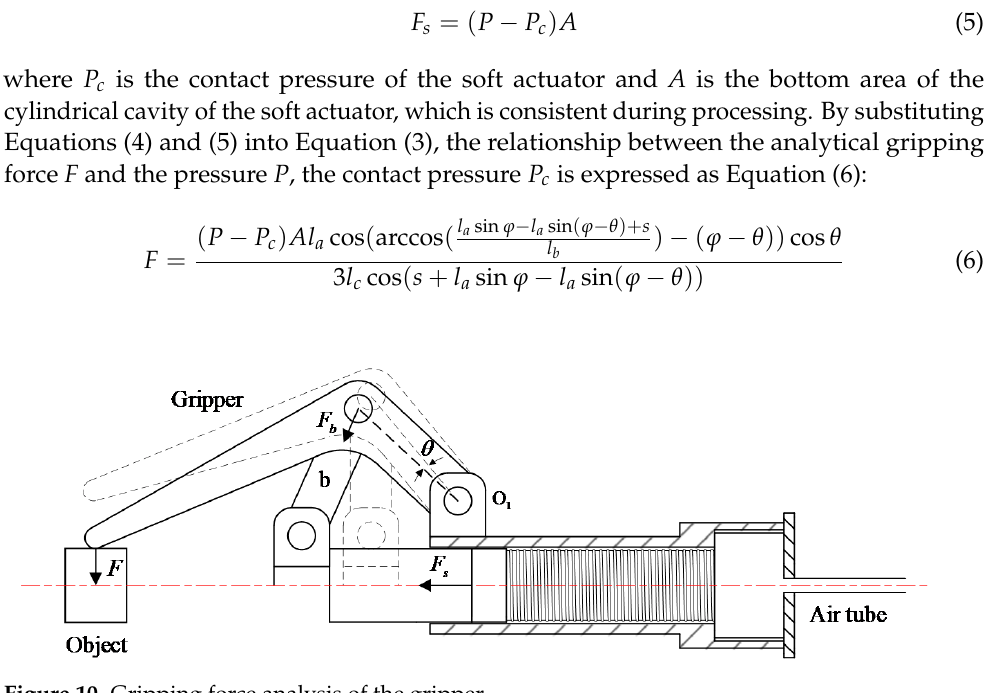
Figure 10. Gripping force analysis of the gripper. The gripper gripped the force sensor to measure the gripping force as shown in Figure 11a. In this experiment, the gripping force thresholds were from 1 to 5 N, with a step size of 0.5 N. The pressure of the soft actuator increased, until the analytical gripping force reached the gripping force threshold. Then, the gripping force measured by the force sensor was recorded. This experiment was carried out 10 times under the same conditions for each gripping force threshold to make sure the repeatability. The relationship between the analytical grasping forces and the measured values was shown in Figure 11b. The black triangles were the analytical gripping force, while the red circles represented the average value of the measured gripping force, and the error bars showed the standard deviations of the measuring. The maximum relative error between the analytical gripping force and the average value of the measured gripping force was 2.1%, indicating that the analytical grasping force was valid. The maximum standard deviation of the measured gripping force was 0.12 N, which was fairly small and indicated that this experiment achieved good